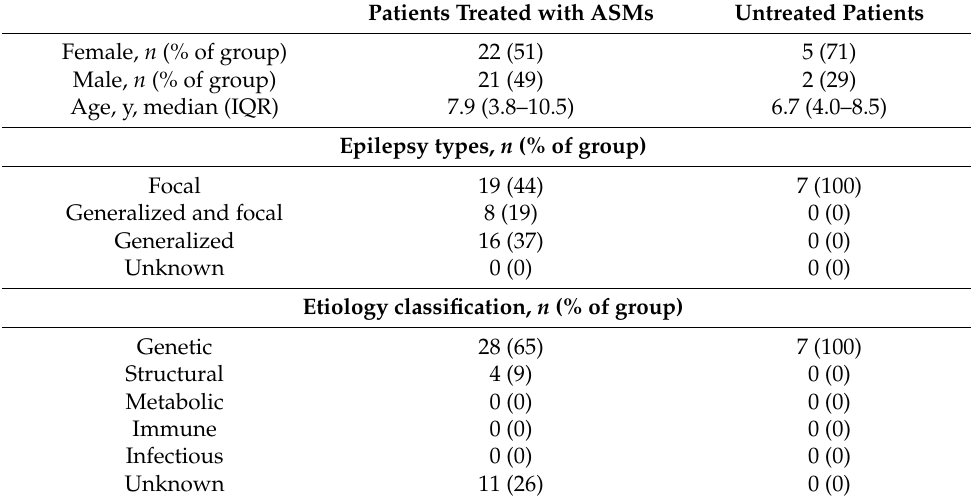
Table 1. Demographic and clinical features of the examined cohort of